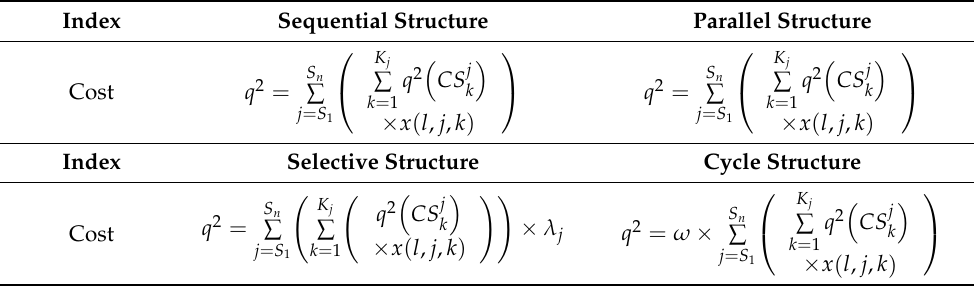
Table 8. QoS expressions of internal composite (Cost).